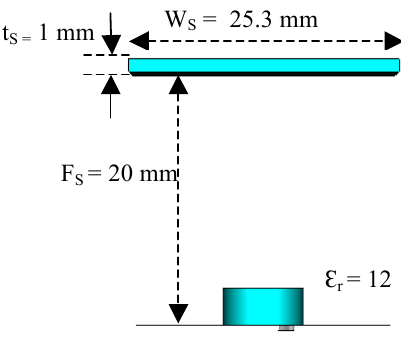
Figure 4: The gain and the axial ratio versus frequency for DRA loaded with dielectric slab compared to a single